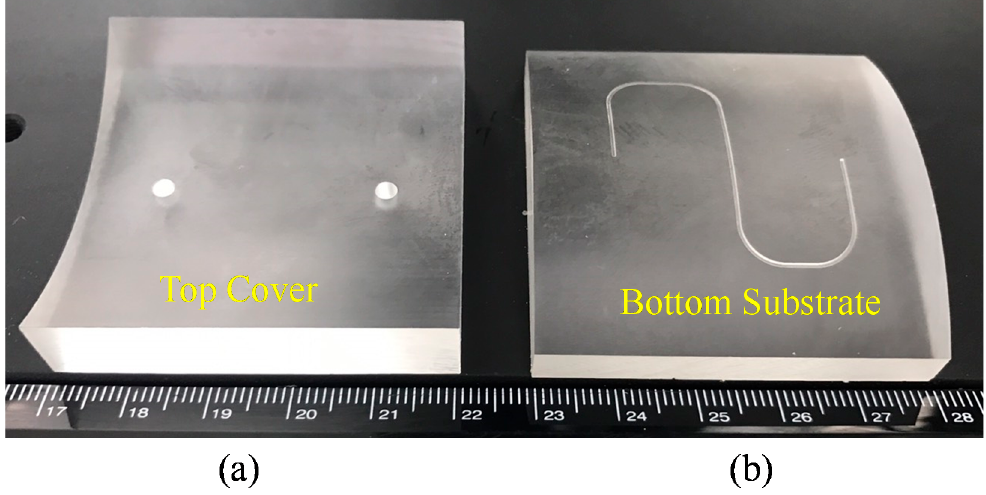
Figure 4. ( a ) Micromachined nonplanar top cover; ( b ) micromachined nonplanar bottom substrate with a S ‐ microchannel.